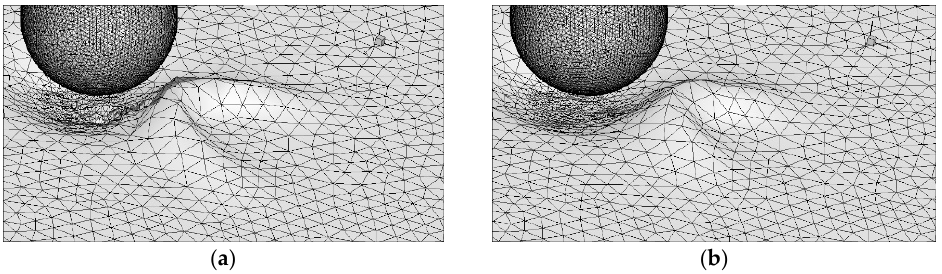
Figure 1. Illustration of the scour beneath a sphere with and without sand-slide model. ( a ) With- out sand-slide model. ( b ) With sand-slide